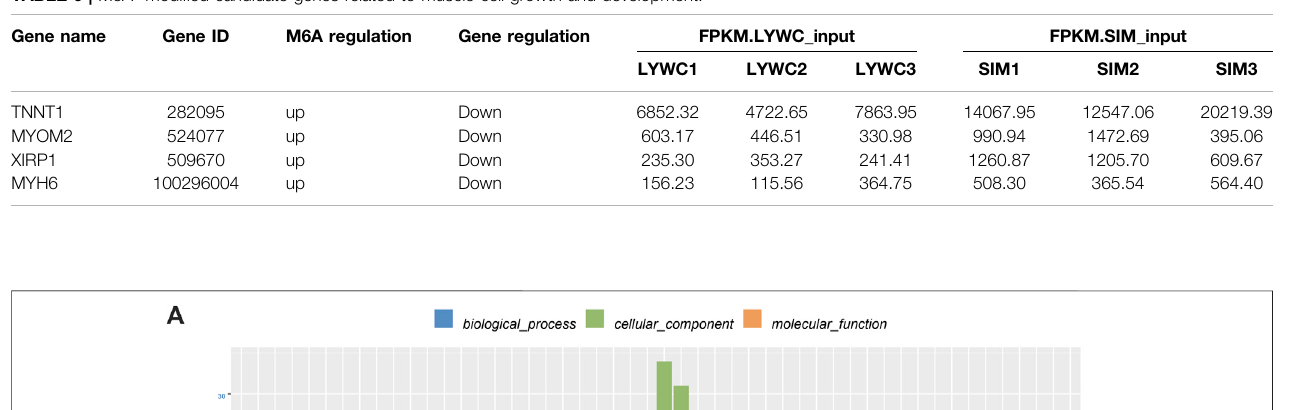
Frontiers in Cell and Developmental Biology |